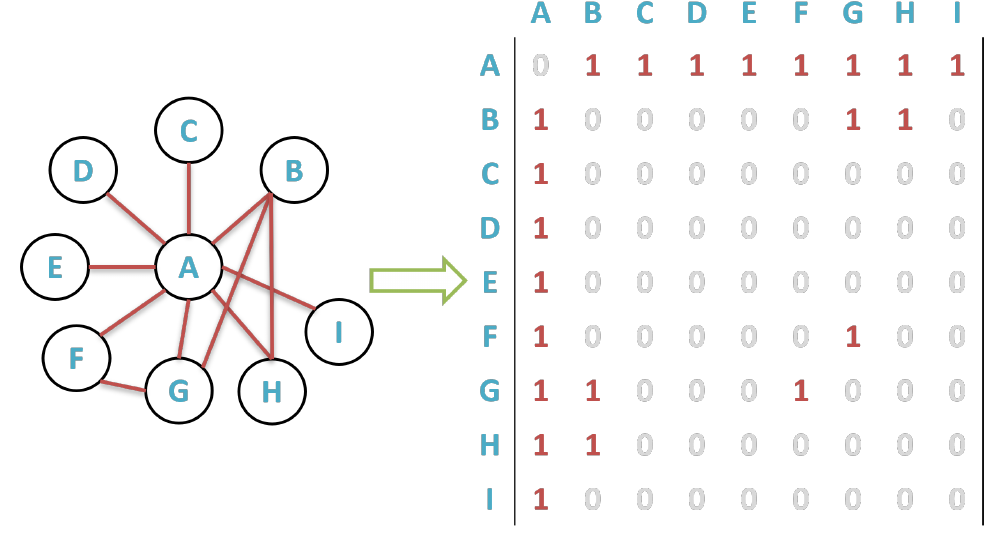
Figure 3. A graph G , and adjacency matrix M